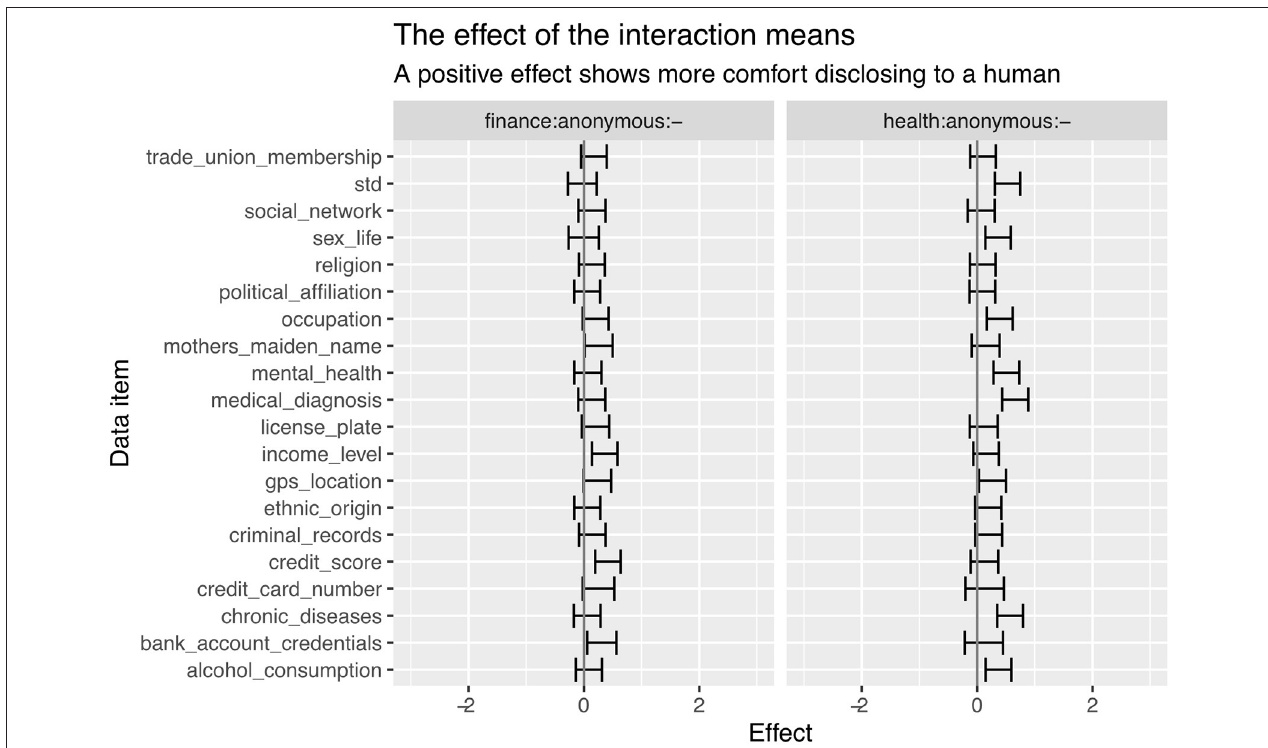
FIGURE 8 | The influence of interaction means across different